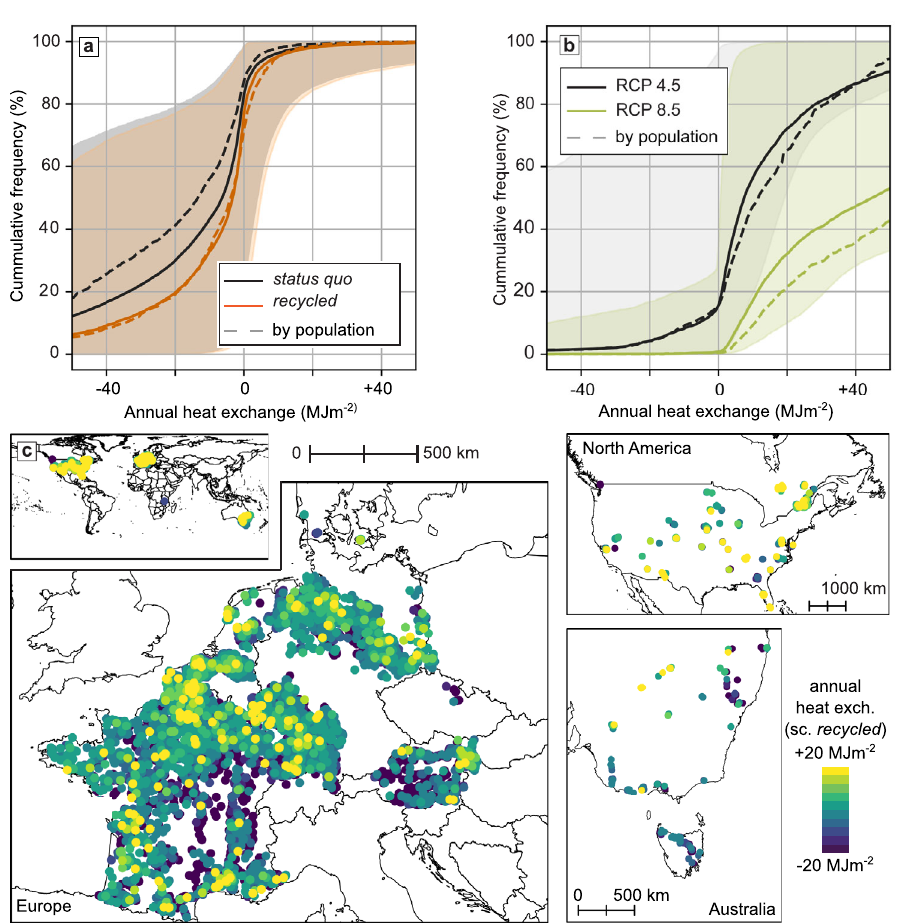
Fig. 4 Annual mean heat exchange under all scenarios. a Cumulative distributions of heat exchange between the groundwater table and the surface and/ or buildings for the status quo (black) and recycled (orange) scenarios. Positive values indicate heat input into the aquifer. The shaded areas indicate our maximum and minimum estimations. Dashed lines indicate population-weighted distributions. To keep the fi gure clear, maximum and minimum population-weighted estimations are not shown. b Cumulative distributions of heat exchange between the groundwater table and the surface and/or buildings in 2095 – 2100 following RCP 4.5 (black) and RCP 8.5 (green). Shaded areas indicate our maximum and minimum estimations. Dashed lines indicate population-weighted distributions. To keep the fi gure clear, maximum and minimum population-weighted estimations are not shown. c Maps of the annual mean heat exchange for the recycled scenarios. A zoomable version of this map, as well as the map for the scenarios under climate change are accessible under